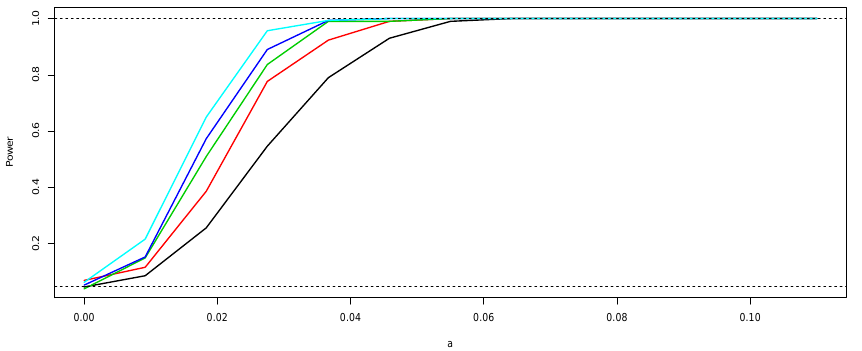
Figure 3. Empirical power of the Wilcoxon test according to a ( t ) = a and n . The black curve corresponds to the power of the test for n = 50 and the light blue curve to the case of n = 150. The other curves correspond to n = 80 (red), n = 100 (green), and n = 120 (dark